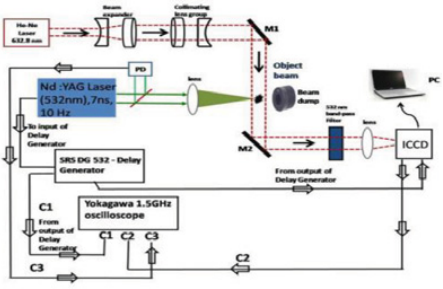
Figure 1. Experimental schematic of shadowgraphy and synchronization of ICCD camera with the laser pulse.